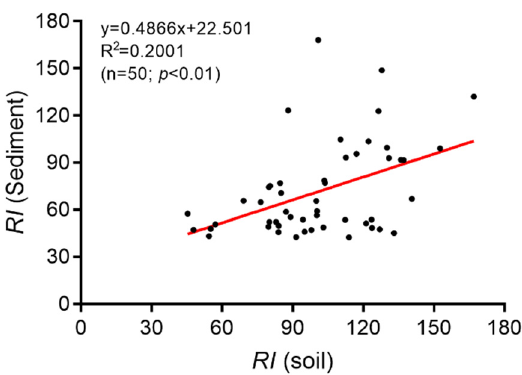
Figure 6. The linear relationship of RI between the soils and its corresponding river sediments.